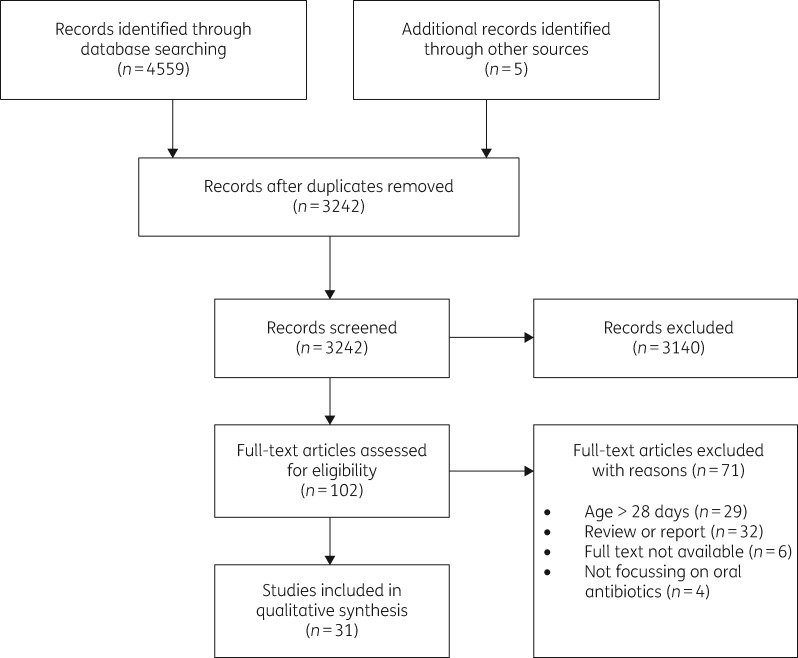
Study selection.